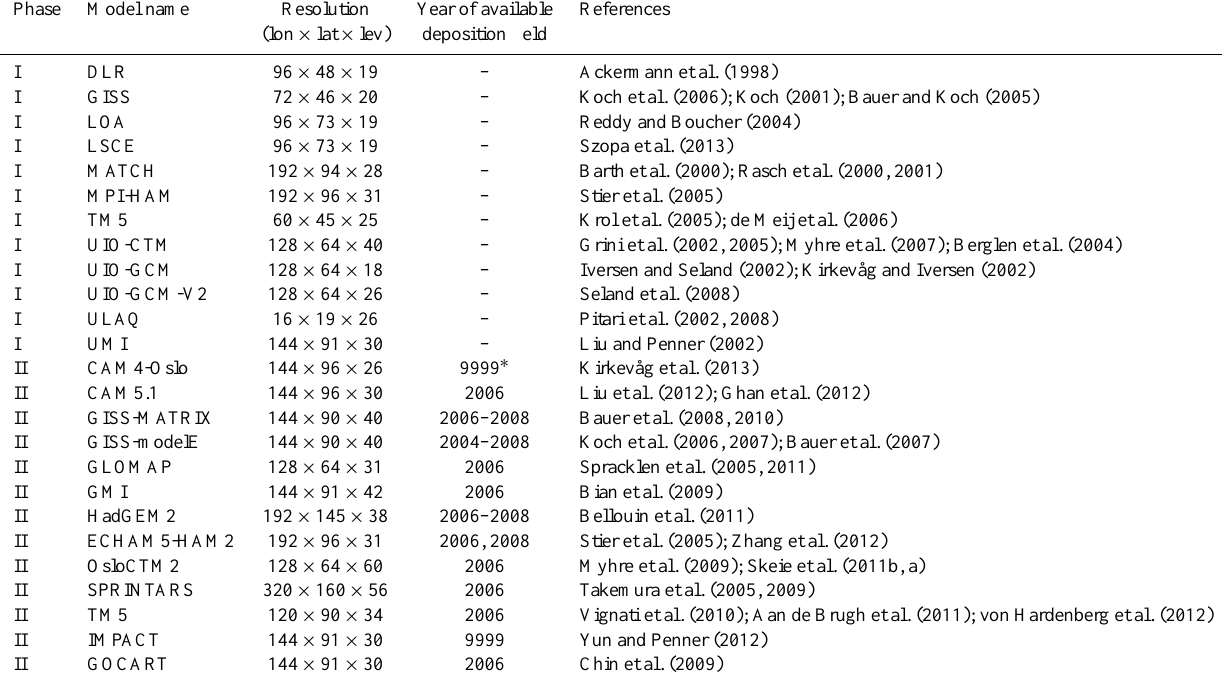
Table 1. Phase I and phase II AeroCom models used in this